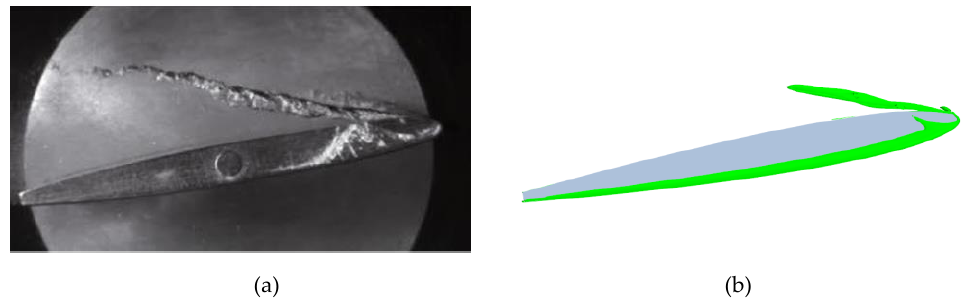
Figure 5. Comparison of experimental TLV trajectory [17] and numerical simulations. ( a ) Experimental results [17] ;( b ) Numerical results.